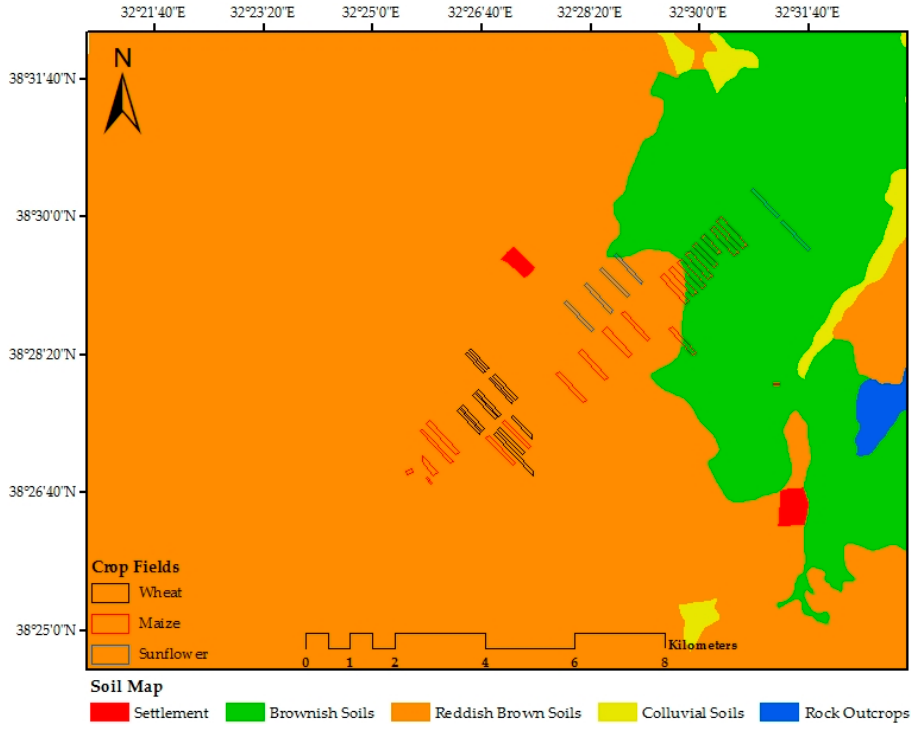
Figure 1. The location map of the study area; general overview (left) and Sentinel-2 RGB image of the study site (right).